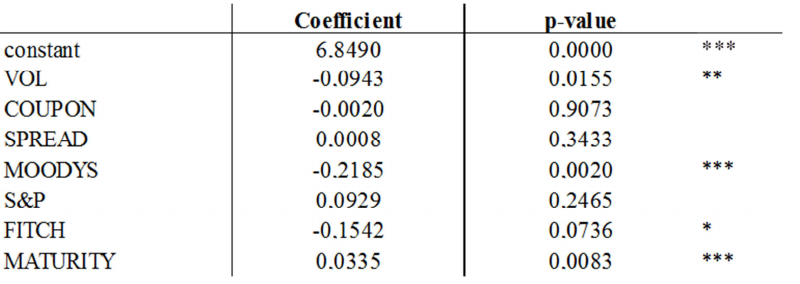
Table 4 – Results of ordinary least